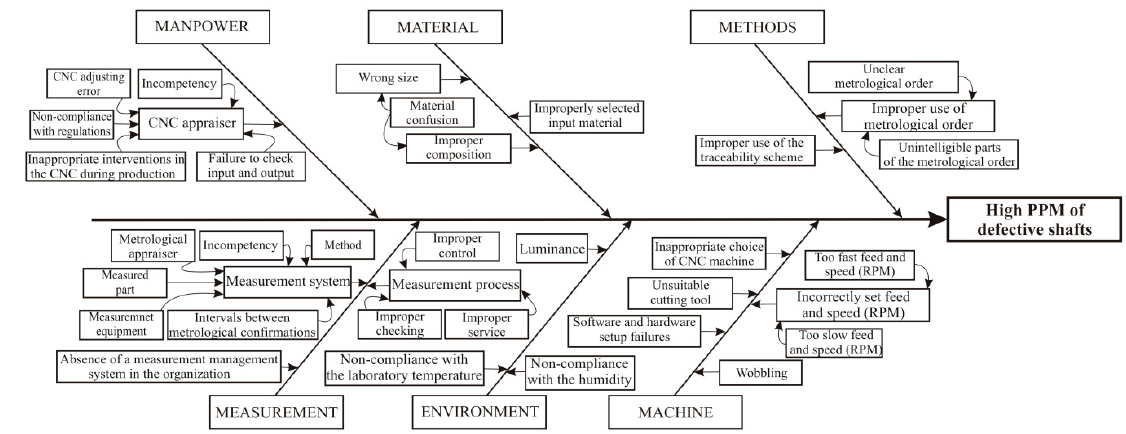
Figure 1. Cause-and-effect diagram (Ishikawa) for the shaft production.